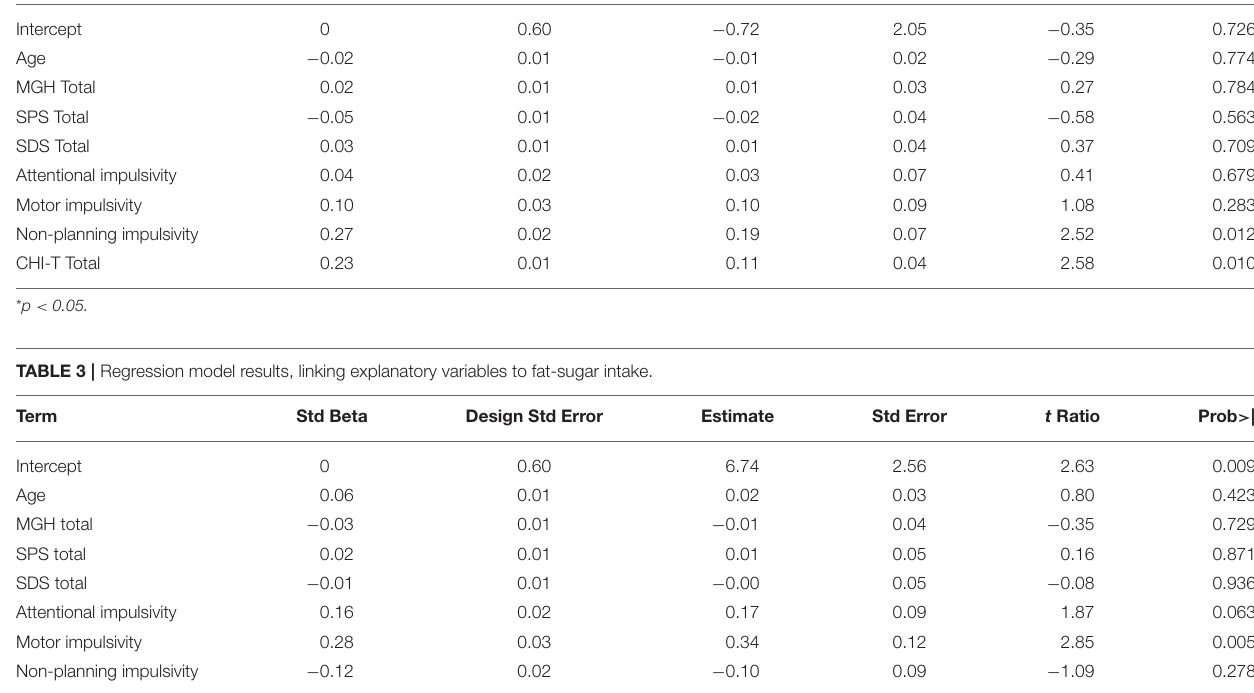
TABLE 2 | Regression model results, linking explanatory variables to sugar intake. Term